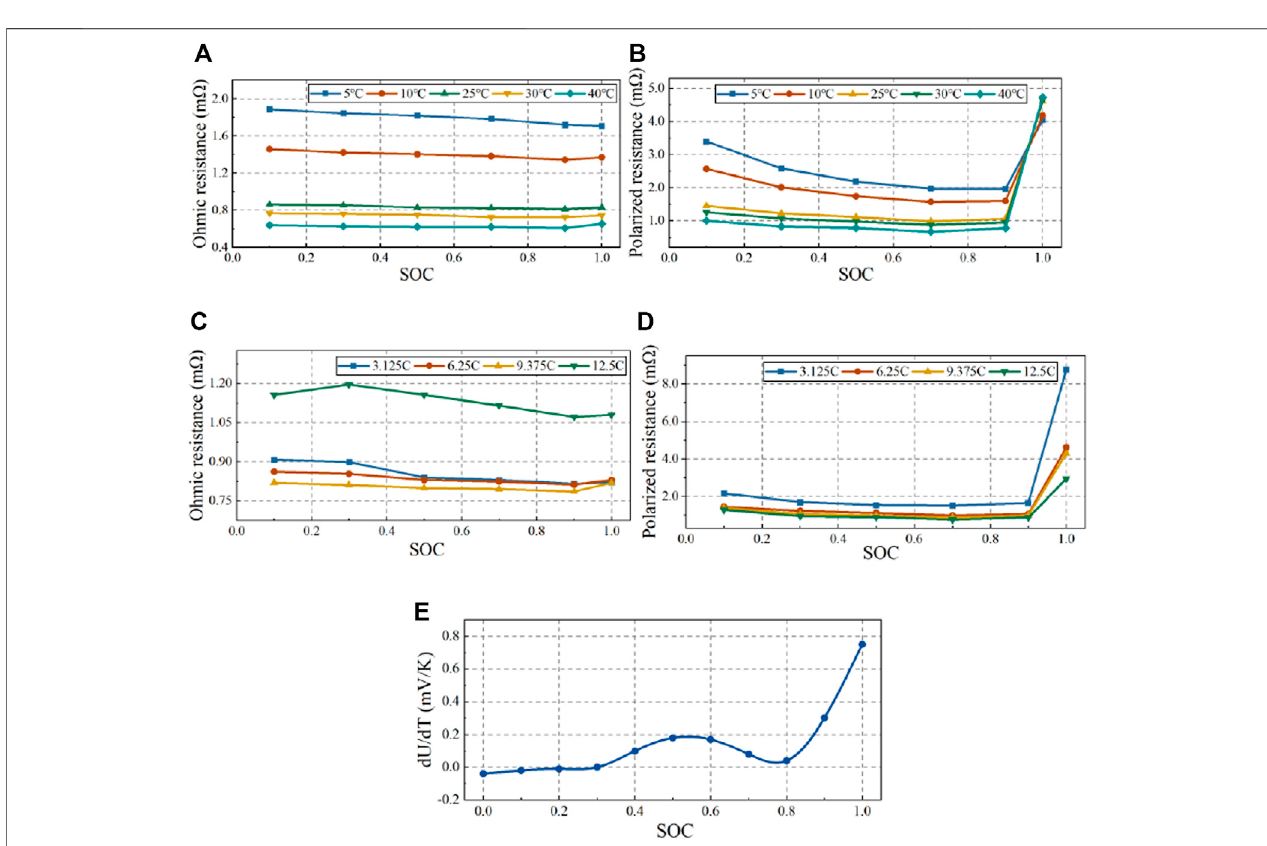
FIGURE 2 | Total resistance and entropy coef fi cient of the pouch battery: (A) ohmic resistance and (B) polarized resistance at a discharge current of 6.25 C; (C) ohmic resistance and (D) polarized resistance at an ambient temperature of 25 ° C; and (E) entropy coef fi cient.